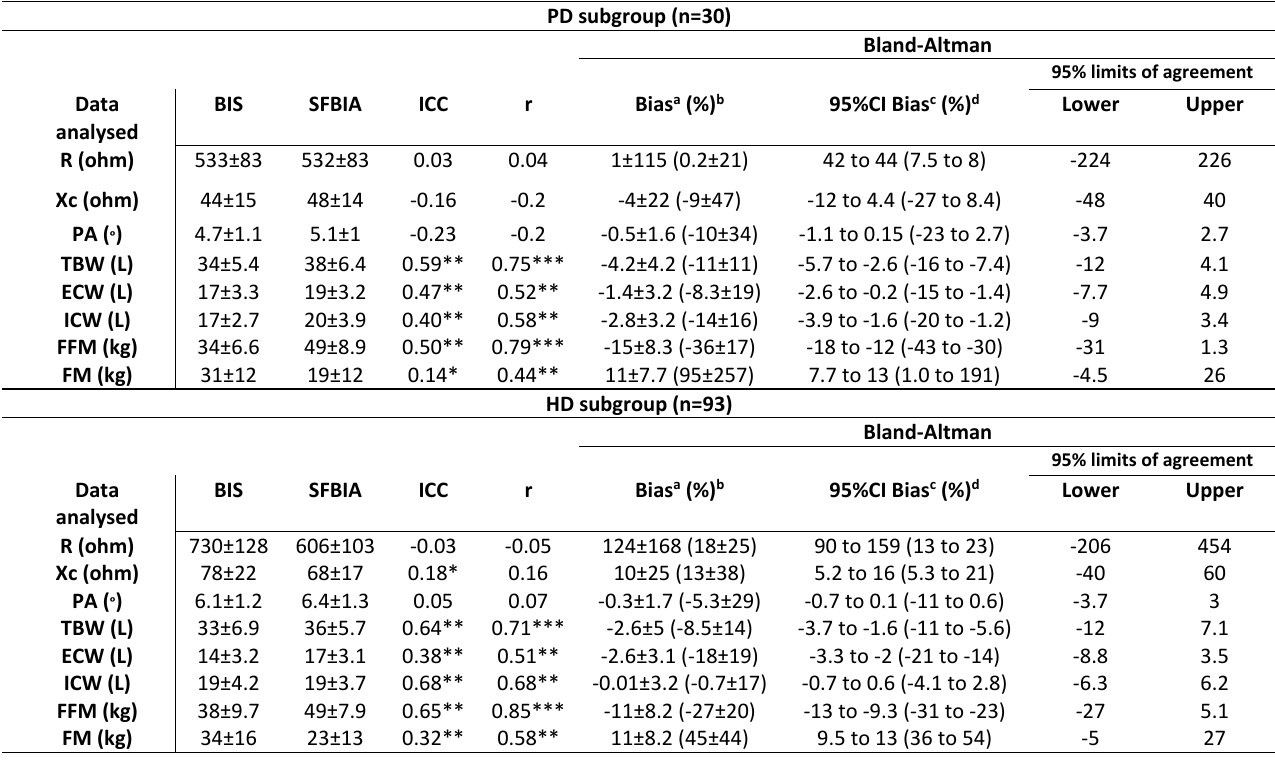
Table 3. Statistics of BIS vs SFBIA data in CKD subjects (PD and HD